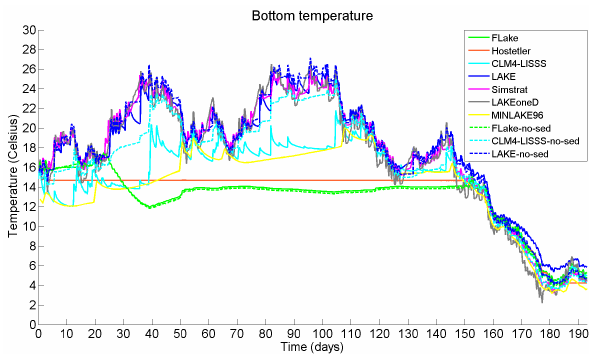
Fig. 6. Time series of bottom temperature of Kossenblatter See produced by models. The time is counted from 00:00GMT, 1 May